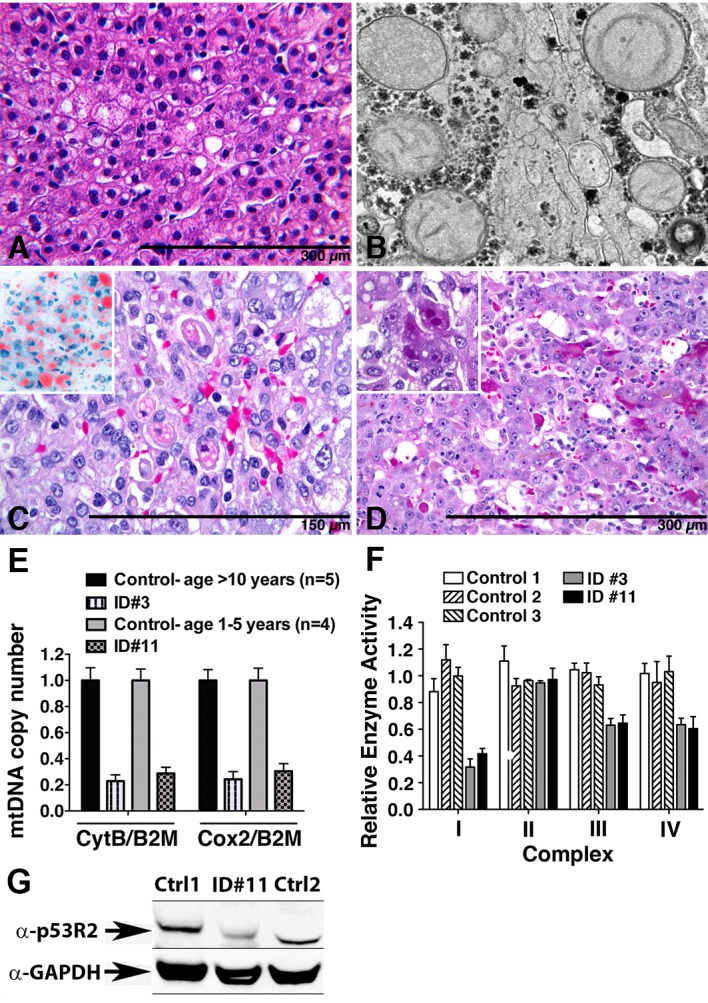
Liver histology, ultrastructure, mtDNA copy number and respiratory complex activity of subjects with heterozygous mutations in RRM2B.(A) Liver biopsy following the second episode of ALF in subject ID#11 showed mild steatosis. H&E stain. (B) Mitochondria at that time were normal in size with pale matrix and subtle haphazard arrangement of cristae. (C and D) Random, non-zonal macro- and microvesicular steatosis was prevalent in H&E- stained sections from the explanted livers of both subjects, confirmed with Oil red O in a frozen section (C, insert). Both explanted livers contained unusual necrotic/apoptotic hepatocytes with distorted contours, granular eosinophilic cytoplasm, and fat droplets. (E) Copy numbers of mtDNA in liver tissues from age-matched control subjects without ALF and from subjects #3 and #11 were determined by qPCR for the mitochondrial genes CytB and Cox2, normalized to the nuclear gene B2M. (F) Respiratory chain complex activities were simultaneously determined on frozen samples from explanted livers of ID#3 and ID#11 and from liver tissue of control subjects without ALF. (G)Total protein extracts from liver tissues from ID#11and from two age-matched controls without ALF were analyzed by SDS-PAGE and immunoblotting against p53R2, the 39kDa gene product of RRM2B.